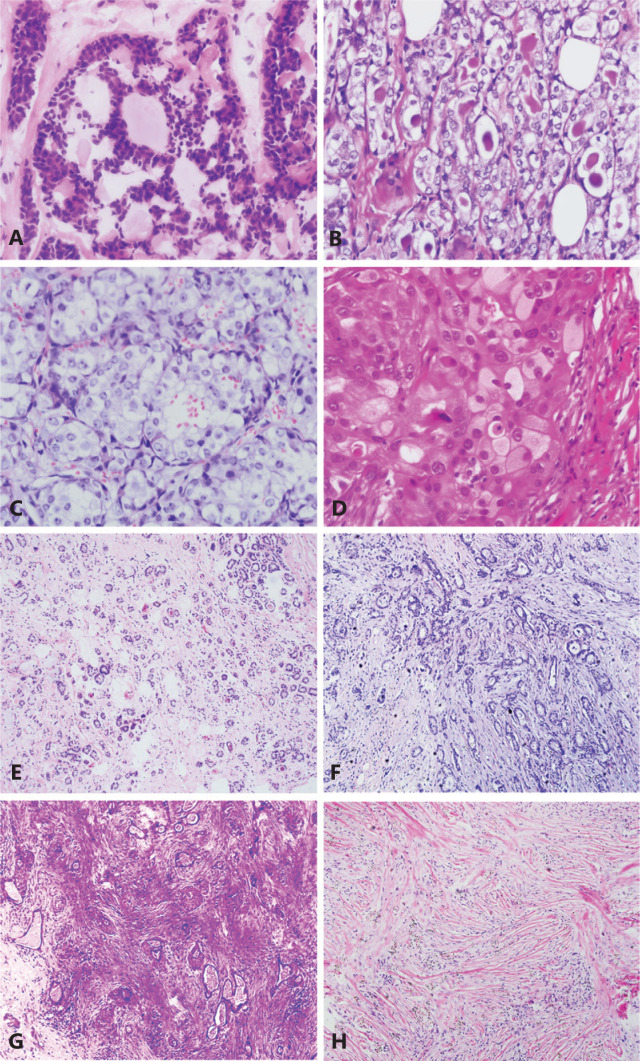
Representative H&E images of rare triple negative breast cancer. (A) Adenoid cystic carcinoma (400×). Most adenoid cystic carcinoma cells surround spherules of basement membrane material constituting pseudolumina. (B) Secretory carcinoma (400×). Abundant intracellular and extracellular secretory material is a typical feature of secretory carcinoma. (C) Acinic cell carcinoma (400×). An example of acinic cell carcinoma with abundant clear cytoplasm. (D) Carcinoma with apocrine differentiation (400×). The example shows cells with abundant, granular, intensely eosinophilic cytoplasm and enlarged nuclei with prominent nucleoli (type A cells). (E) Microglandular adenosis (100×). Haphazard proliferation of small round glands with open lumina composed of a single layer of flat to cuboidal epithelial cells is seen. (F) Carcinoma arising in microglandular adenosis (100×). Carcinoma arising in microglandular adenosis shows a more complex and disordered architecture. (G) Low-grade adenosquamous carcinoma of the breast (200×). The example shows well-developed glandular and tubular formation closely admixed with solid nests of squamous cells on a spindle-cell background. (H) Low-grade fibromatosis-like metaplastic carcinoma (200×). An example of low-grade fibromatosis-like metaplastic carcinoma composed of deceptively bland-looking spindle cells arranged in wavy, interlacing fascicles is shown.